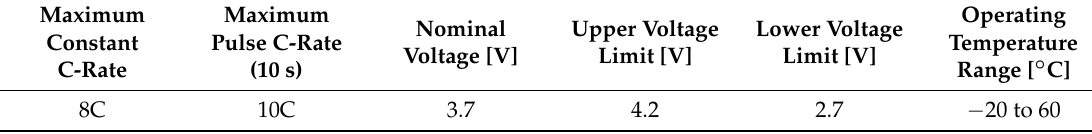
Table 1. Performance Characteristics of 40 Ah Lithium-ion Pouch Cell.